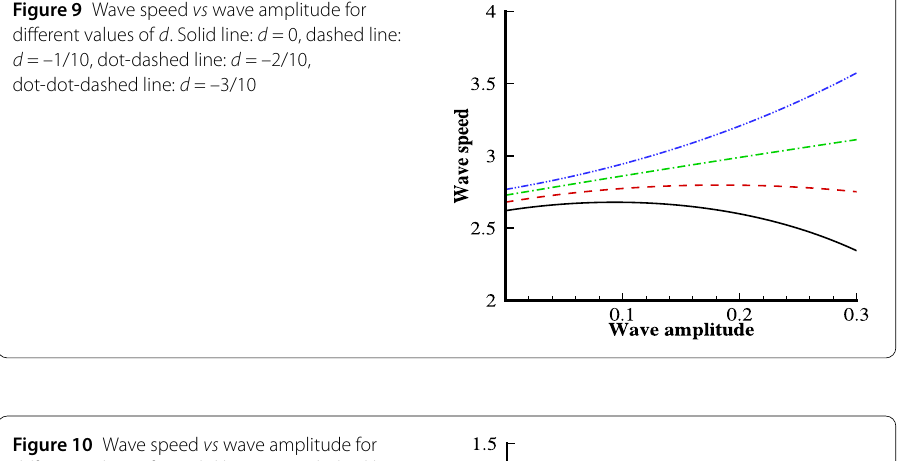
Figure 10 Wave speed vs wave amplitude for different values of τ . Solid line: τ = 0, dashed line: τ = 0.4, dot-dashed line: τ = 0.6, dot-dot-dashed line: τ = 0.8